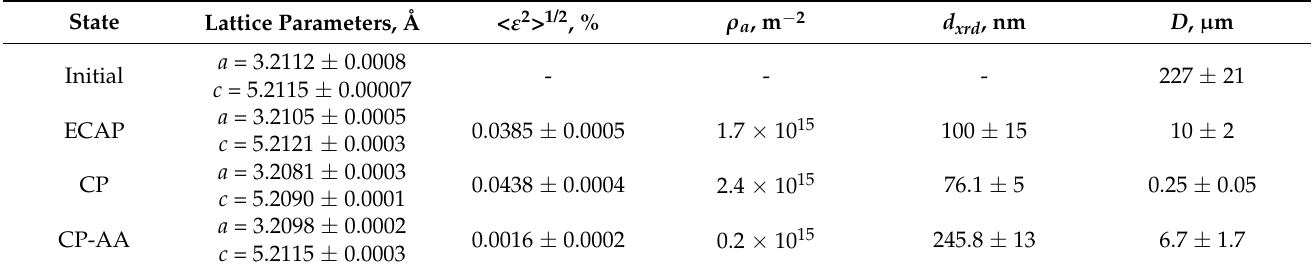
Table 1. The microstructure parameters calculated through the XRD analysis: the lattice parameters a and c , coherent domain size D , density of a -dislocations ρ , microstrain < ε 2 > 1/2 and grain size d calculated from TEM images for the Mg-2Sr in different structural